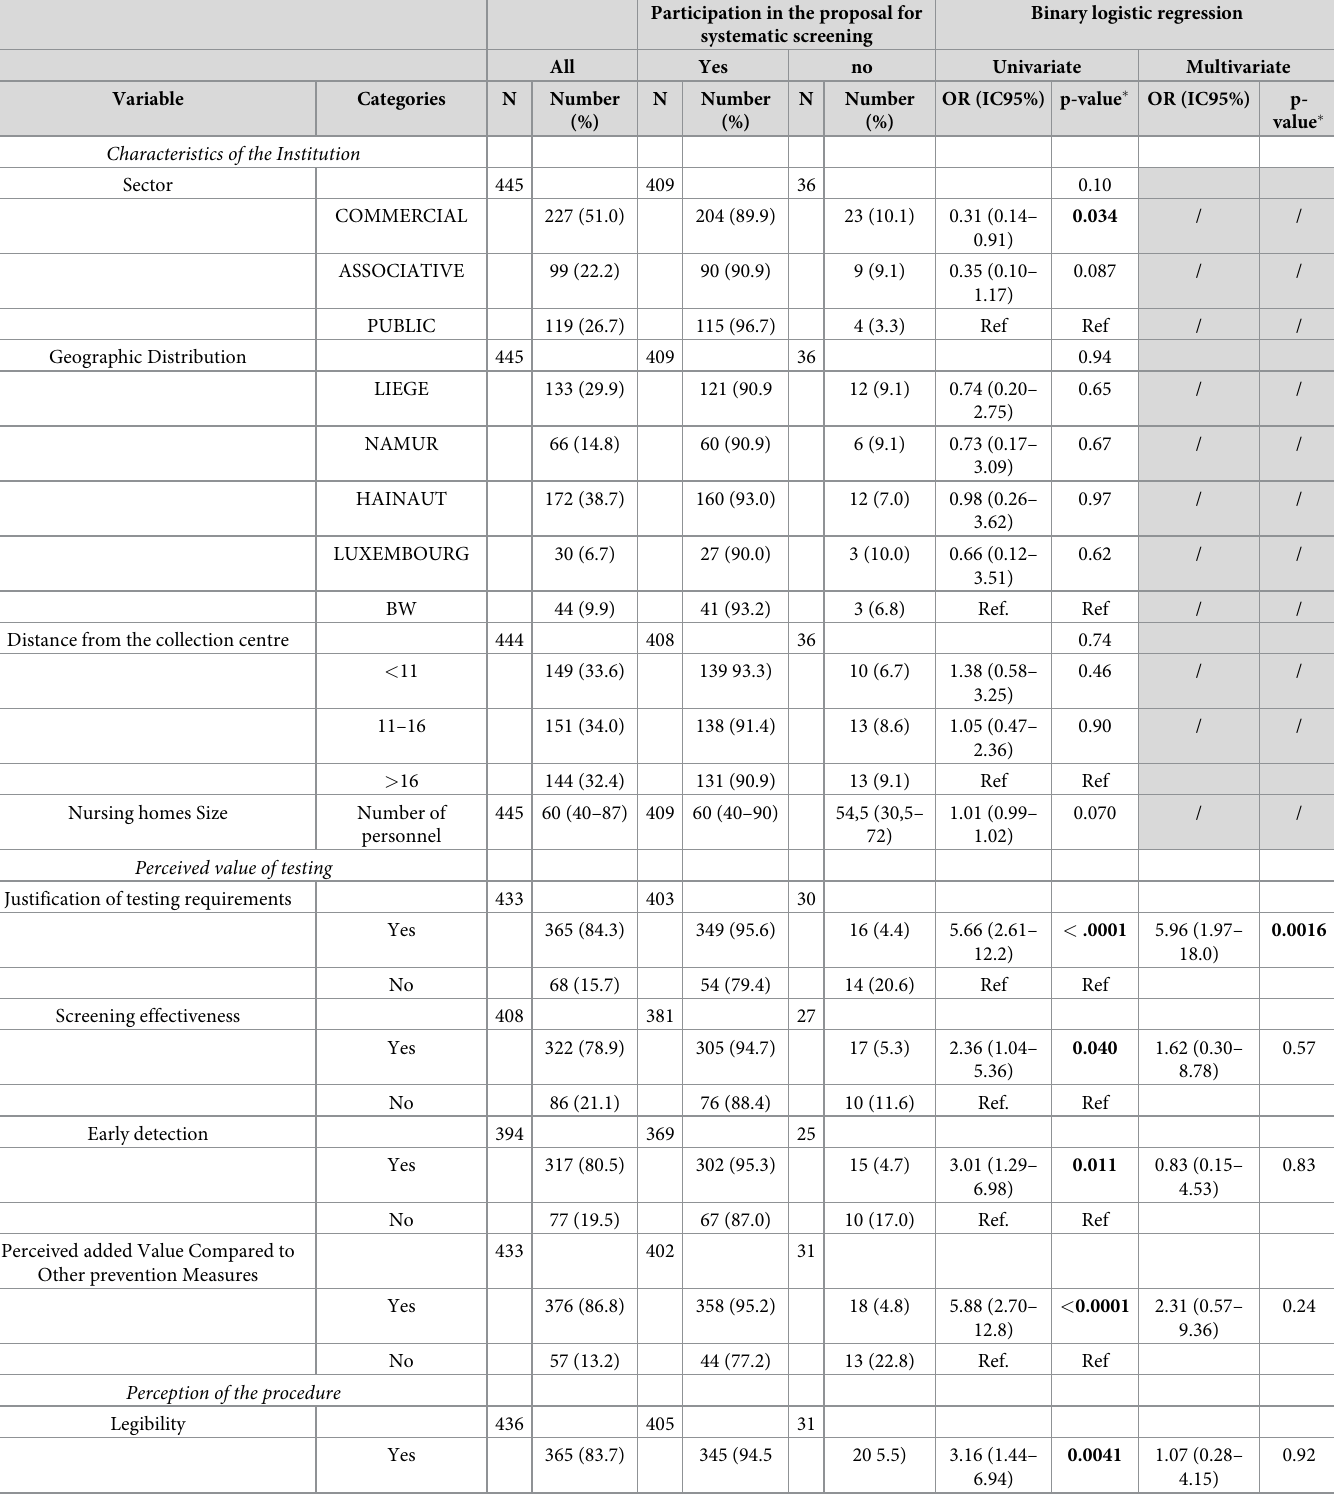
Table 1. Factors determining the adoption of a systematic saliva testing system by Walloon nursing homes for staff to control the spread of Covid-19 (n = 445, December